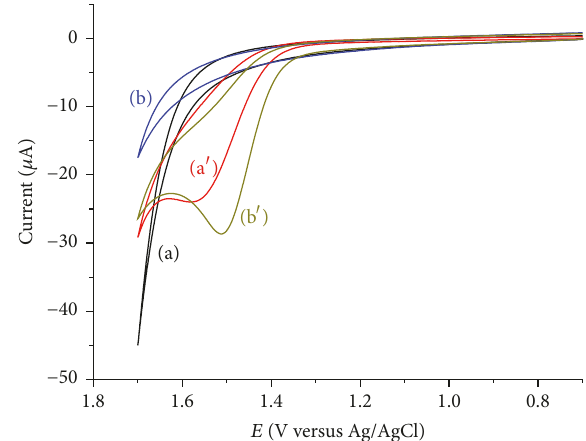
Figure 1: CVs of unmodified GCE (a and a 󸀠 ) and LGCE (b and b 󸀠 ) in pH 5 ABS containing no (a and b) and 1 mM (a 󸀠 and b 󸀠 ) caffeine.